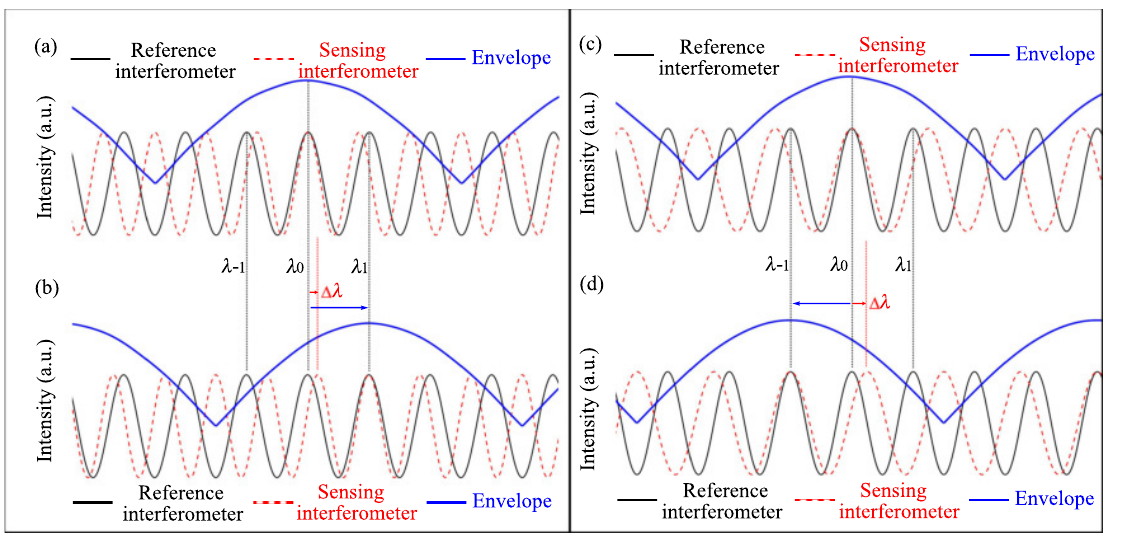
Figure 3. The relationship between the wavelength shift of the Vernier effect envelope and individual spectrum: ( a ) FSR r > FSR s , initial spectrum; ( b ) FSR r > FSR s , both the sensing spectrum and the Vernier envelope redshift; ( c ) FSR r < FSR s , initial spectrum; ( d ) FSR r < FSR s , sensing spectrum redshifts, the Vernier effect envelope blue